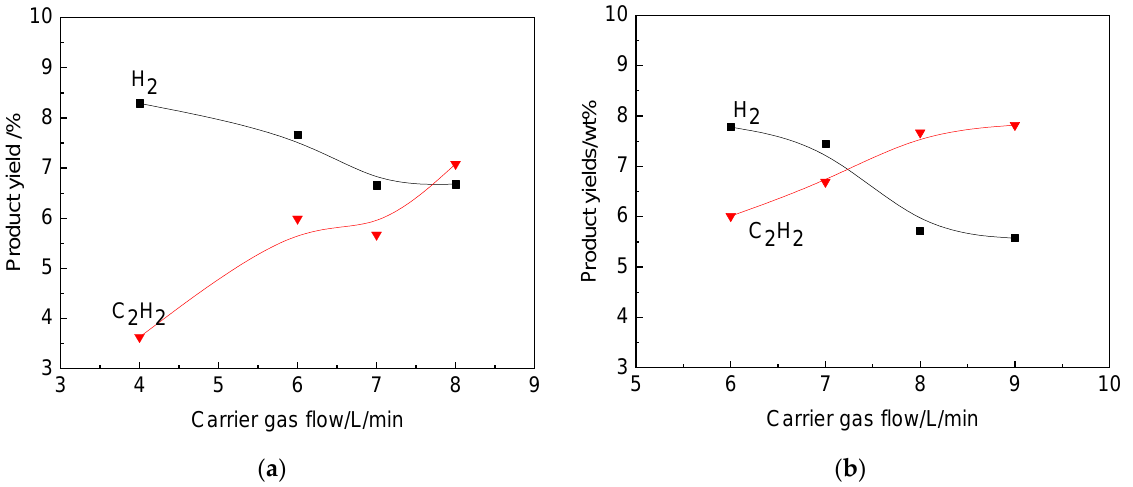
Figure 3. Influence of residence time on the yields of H 2 and C 2 H 2 . ( a ) residence time 24~48 ms. ( b ) residence time 8~12 ms.